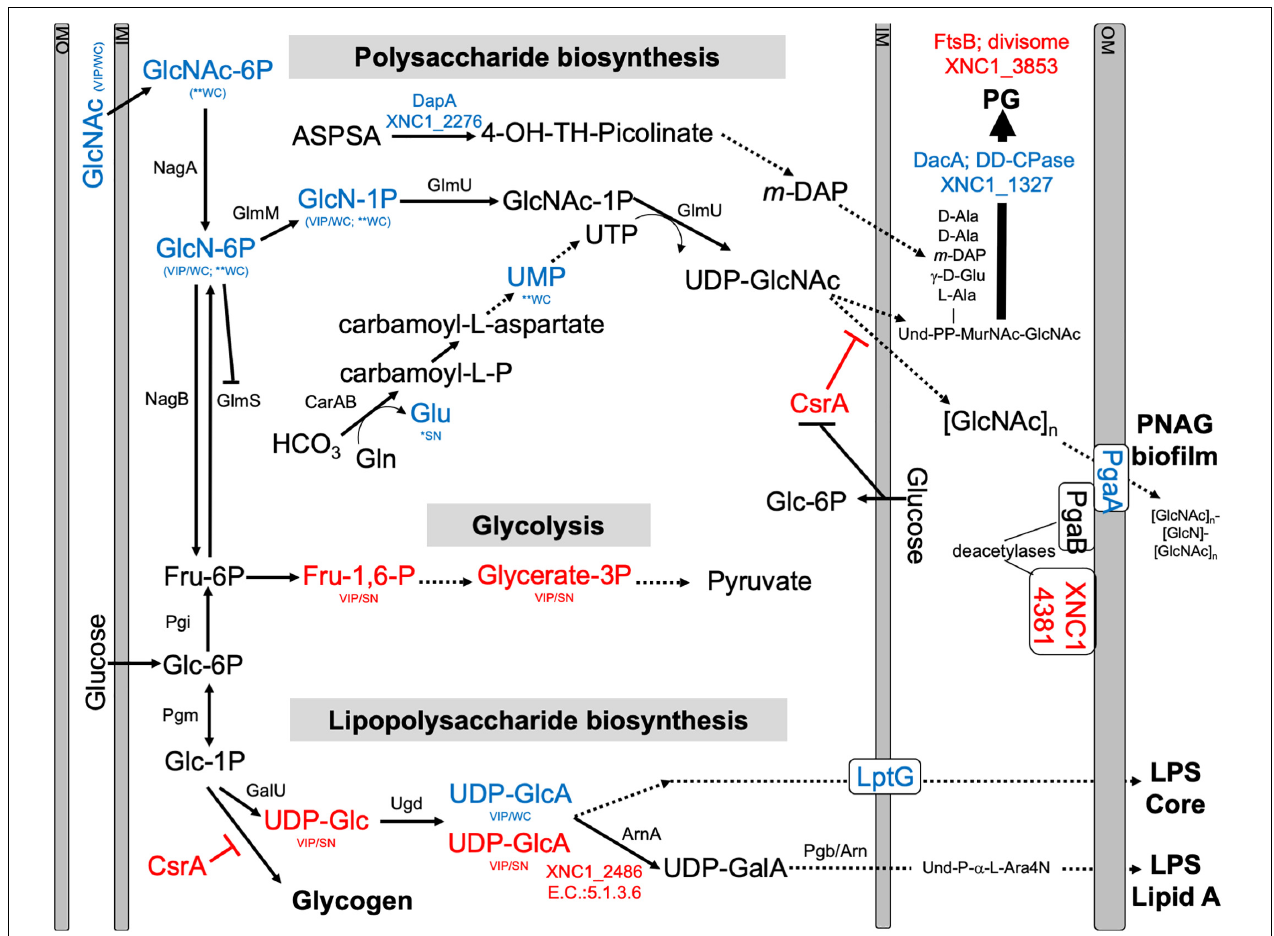
FIGURE 7 | Predicted pathways for amino sugar metabolism leading to peptidoglycan (PG), exopolysaccharide [poly- N -acetylglucosamine (PNAG)], lipopolysaccharide LipidA biosynthesis, and glycolysis pathways. Blue and red font texts indicate higher and lower abundance of the indicated metabolites and proteins in WT relative to (cid:49) SR1 . Asterisks (*) indicate significant differences based on Student’s T -test, while VIP indicates VIP > 1 in PLS-DA plots, with WC and SN indicating whether the observed difference was in a whole cell or supernatant, respectively. XNC1_4381 shows similarity to PgaB deacetylase, and XNC1_2486 is predicted to convert UDP-glucuronate (UDP-GlcA) to UDP-galacturonate (UDP-GalA), similar to the enzyme ArnA. GlcNAc-6P, N -Acetyl-Glucosamine; GlcN-6P, Glucosamine-6-phosphate; GlcN-1P, Glucosamine-1-phosphate; GlcNAc-1P, N- Acetyl-Glucosamine-1-phosphate; UDP-GlcNAc, Uridine diphosphate N- acetyl glucosamine; Und, Undecaprenyl; MurNac, N- Acetyl-Muramic Acid; Fru-6P, Fructose-6-phosphate; Fru-1,6-P, Fructose 1,6 bisphosphate; Glycerate-3P, 3-Phosphoglycerate; Glc-6-P, Glucose-6-phosphate; Glc-1P, Glucose-1-phosphate; UDP-Glc, Uridine diphosphate glucose; UDP-GlcA, Uridine diphosphate glucuronate; UDP-GalA, Uridine diphosphate galacturonate; L -Ara4N, L -4-aminoarabinose. Dashed lines indicate multiple steps in the indicated